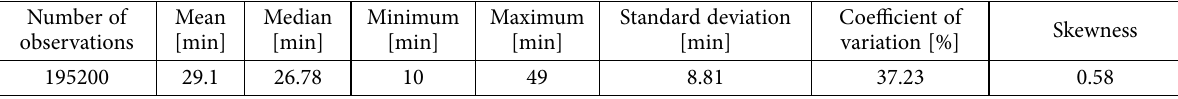
Table 1. Measurements of descriptive statistics for the current maintenance state for all vehicles Number of